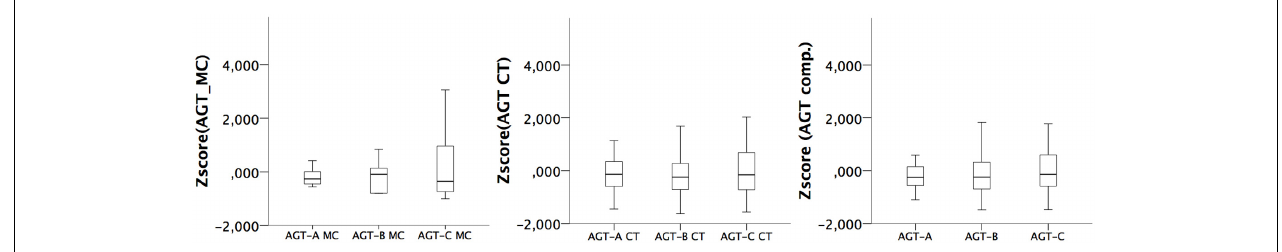
FIGURE 3 | Boxplot charts for AGT-related